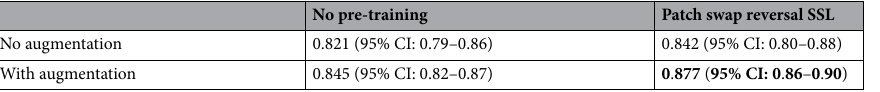
Table 1. The results from the ablation study: the mean and 95% Confidence Interval of the area under the ROC curves measured using 5-fold cross validation. The bold value indicates the highest accuracy permutation of the pre-training and augmentation variations.